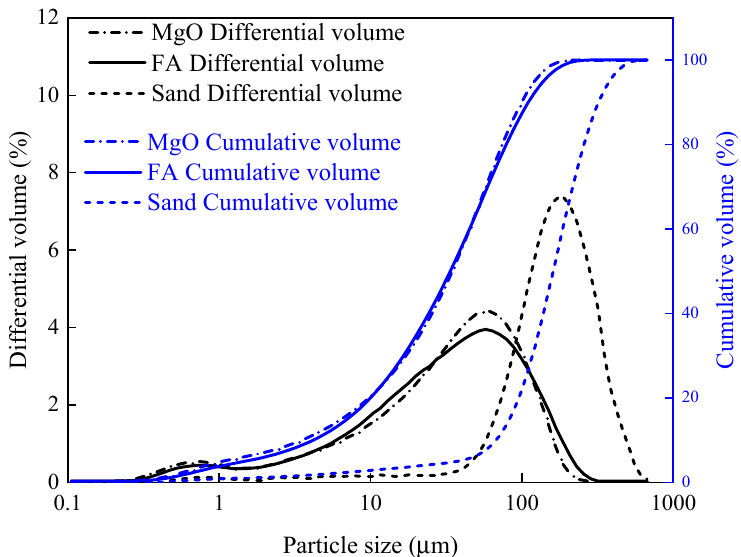
Figure 2. Particle size distribution of MgO, FA, and quartz sand. Table 4. PVA fiber performance indicators.